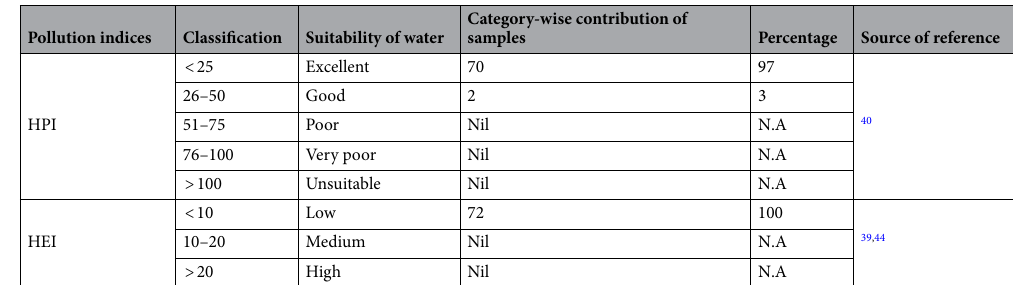
Table 8. Suitability of water based on HPI and HEI and their percent sharing in the study area (N = 72). N.A. not applicable.